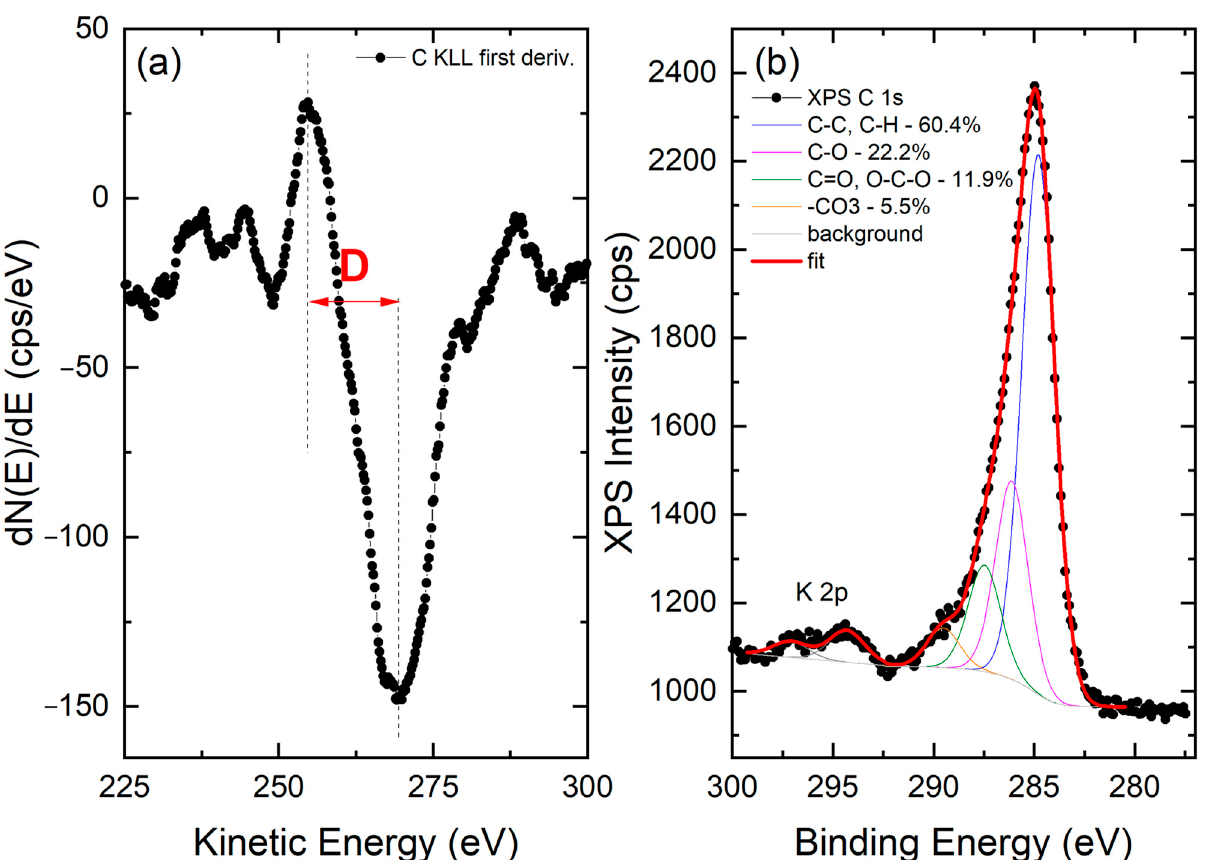
Figure 3. ( a ) First derivative of the C KLL X-ray-induced Auger spectrum acquired on the nC- RHA@SiO 2 sample. The positions of the most positive maximum and of the most negative minimum are marked as vertical dashed lines. The distance in energy between the two positions defines the so-called D parameter, as marked. ( b ) XPS C 1s spectrum collected on the same sample. The results of the best fitting procedure are reported as well.